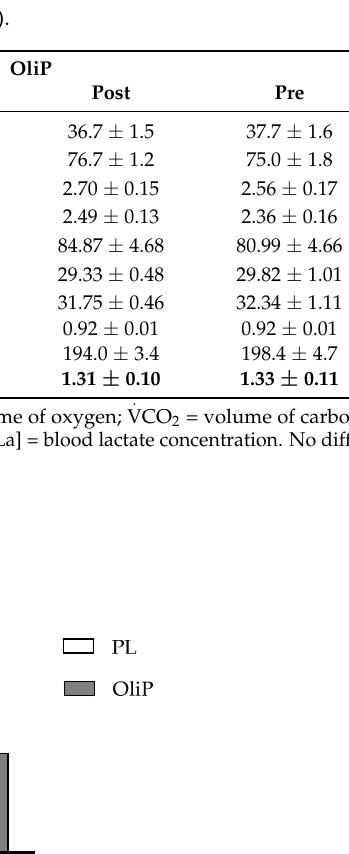
Table 4. Physiological responses for both groups during the demanding aerobic session at visit 2 (pre-intervention) and 4 (post-intervention).